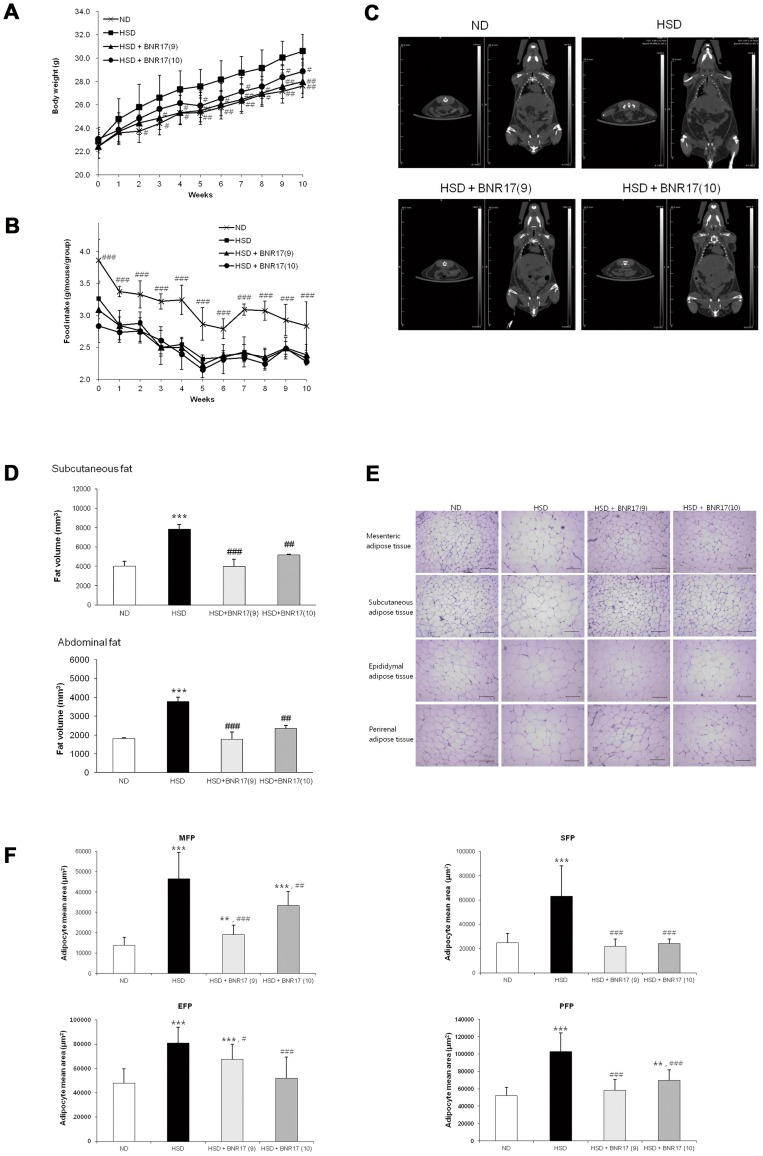

L. gasseri BNR17 supplementation decreases high-sucrose diet-induced body weight gain and fat mass accumulation.(A) Change in body weight, (B) change in food intake, (C) representative CT scanning images of abdominal (left) and whole body (right) fat accumulation (in black) at 10 weeks (D) correspond to the volume of subcutaneous and abdominal fat, (E) representative adipose tissue-staining images in mice of four groups, (F) adipocyte mean area (µm2). Data represent the means ± SD. Pairwise t-test: *P<0.05, **P<0.01, ***P<0.001 versus the ND group; #
P<0.05, ##
P<0.01, ###
P<0.001 versus the HSD group.